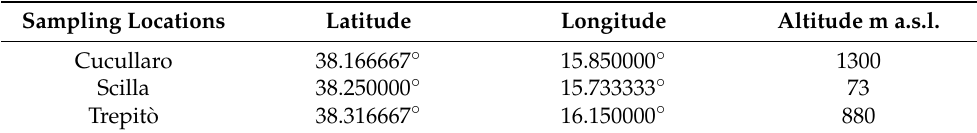
Table 1. Sampling Table 1. Sampling locations.